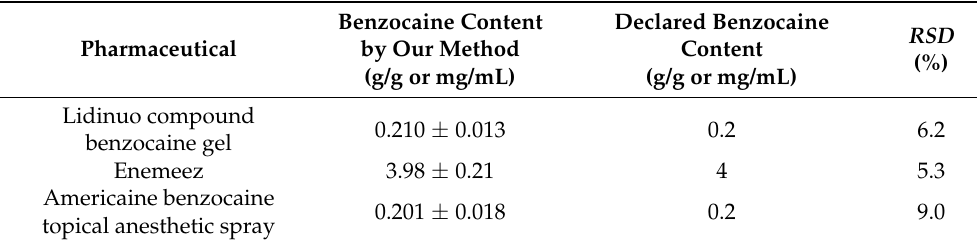
Table 1. Content of benzocaine in selected pharmaceuticals, determined using the method in this work together with content declared by the manufacturer.